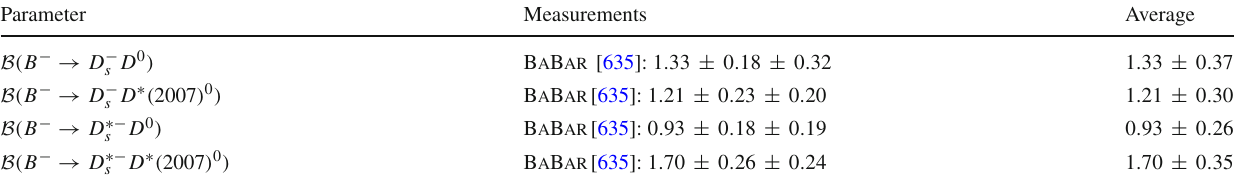
Table 153 Decays to D